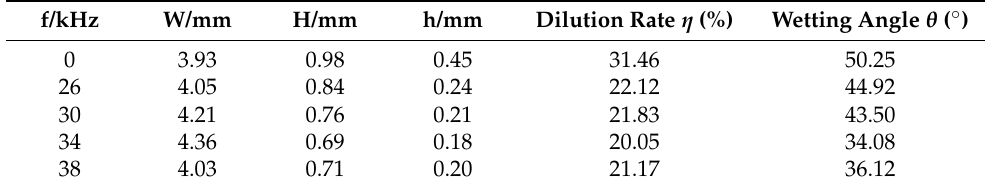
Table 2. The width, height, dilution rate and wetting angle of the cladding layer with different ultrasonic